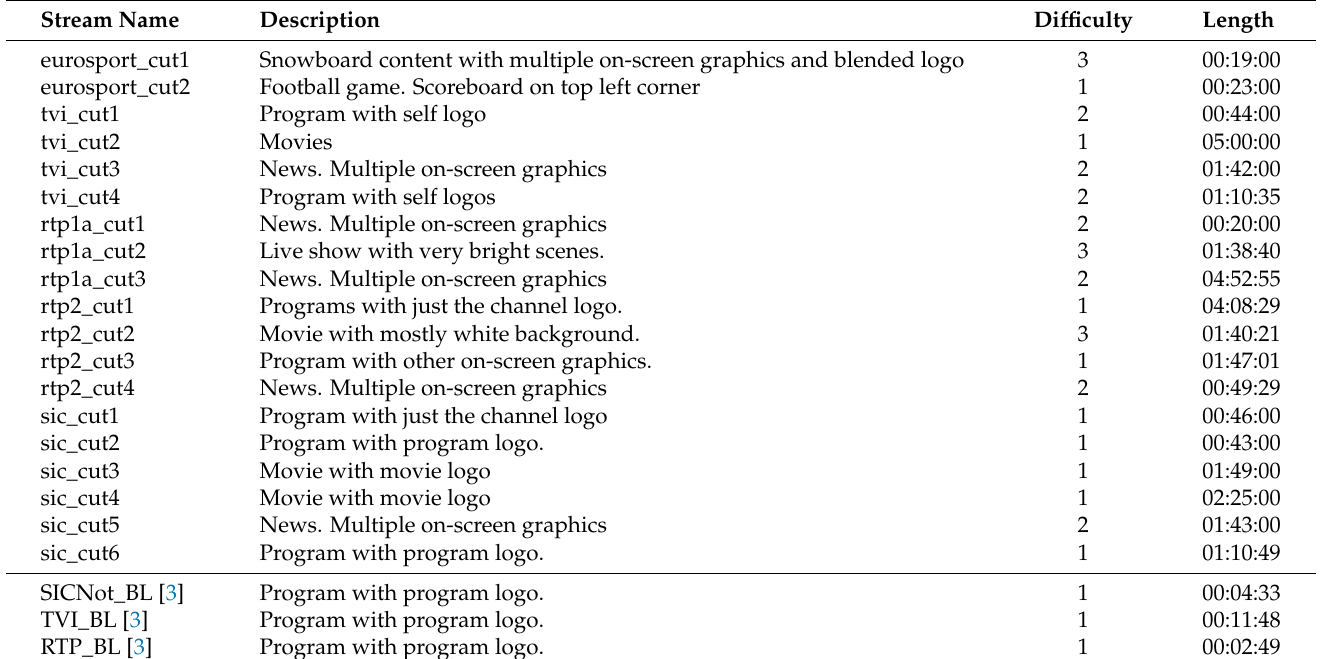
Table 4. Description of the substreams obtained from the original